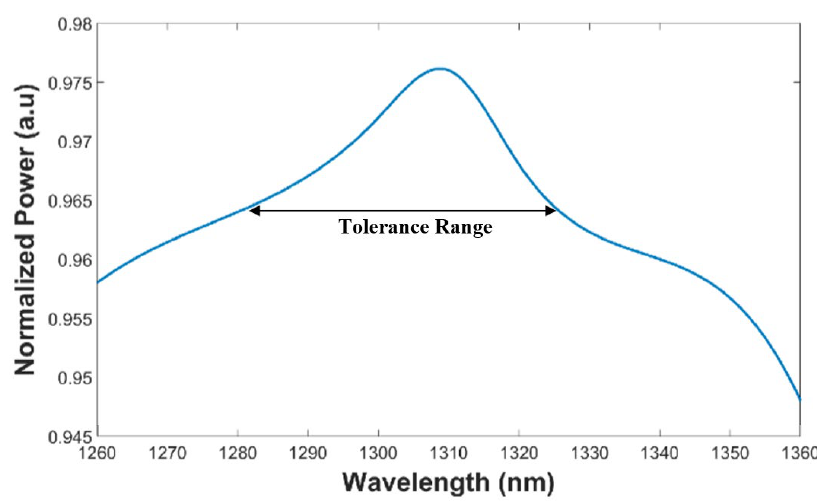
Figure 6. Normalized optical power of the MMI combiner versus wavelength over the O-band spectrum.